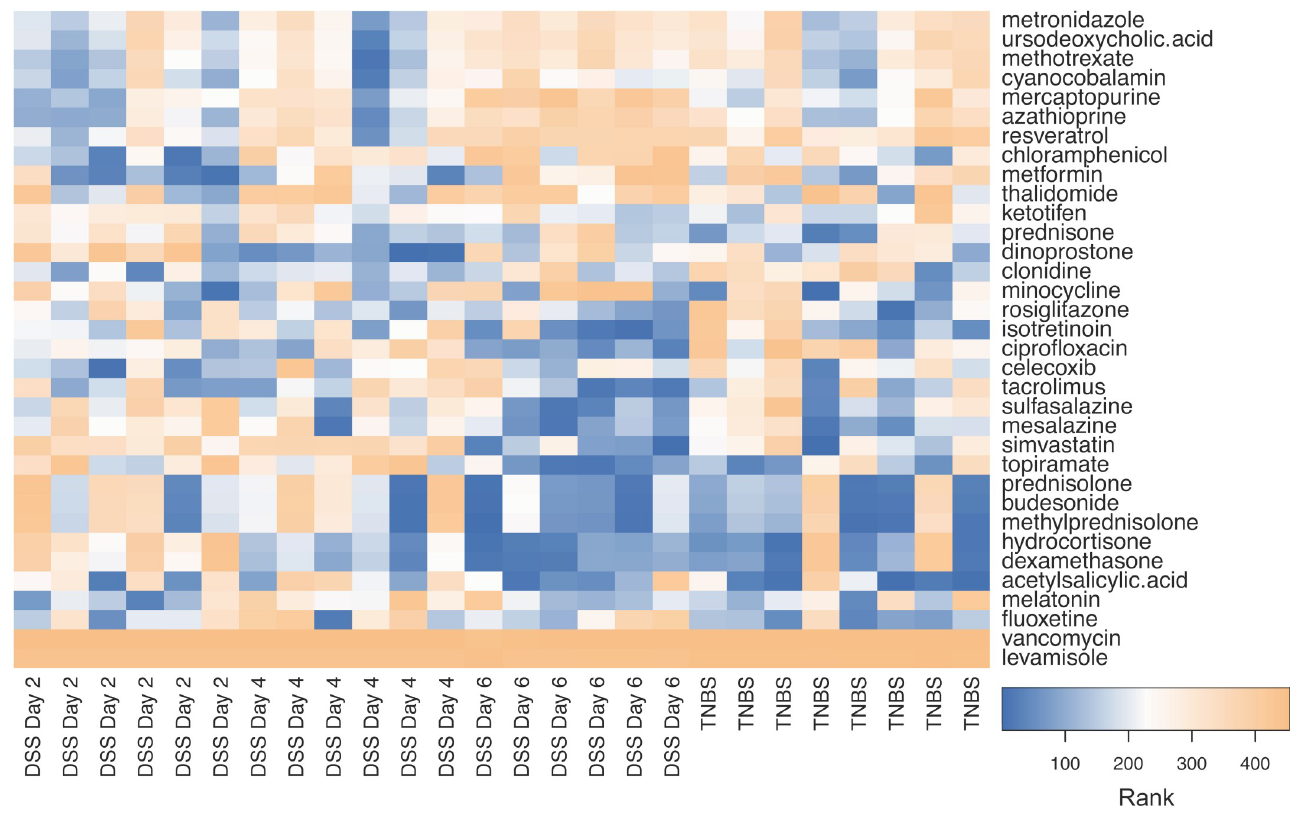
Fig 6. Heatmap showing drug ranks for IBD related drugs for two mouse IBD colonic sample studies from GEO. Blue indicates a drug with higher predicted efficacy and orange indicates one with lower predicted efficacy.